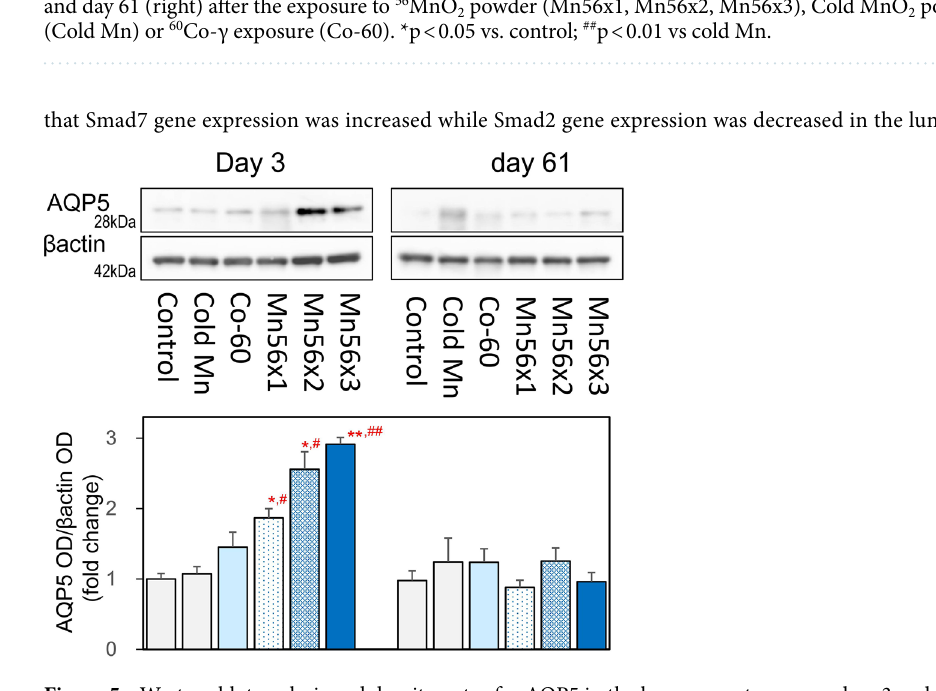
Figure 5. Western blot analysis and densitometry for AQP5 in the lung on postexposure days 3 and 61. β-Actin was presented as an internal control. Lysates extracted from the lung were examined. *p < 0.05, **p < 0.01 vs. control; # p < 0.05, ## p < 0.01 vs cold